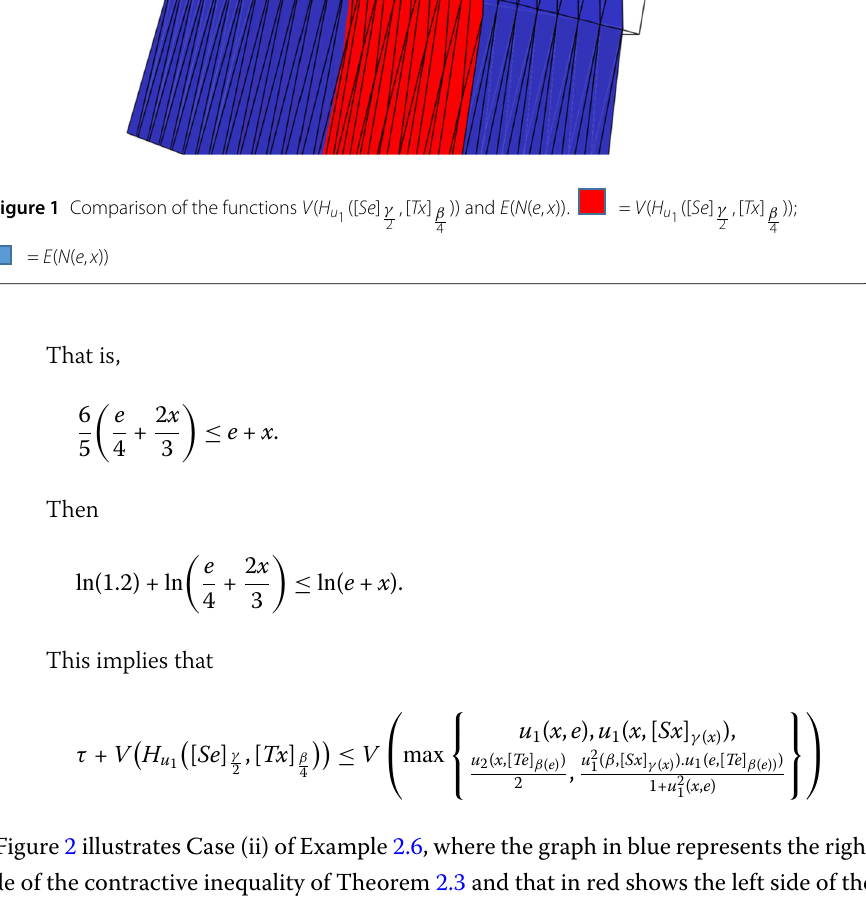
Figure 1 Comparison of the functions V ( H u